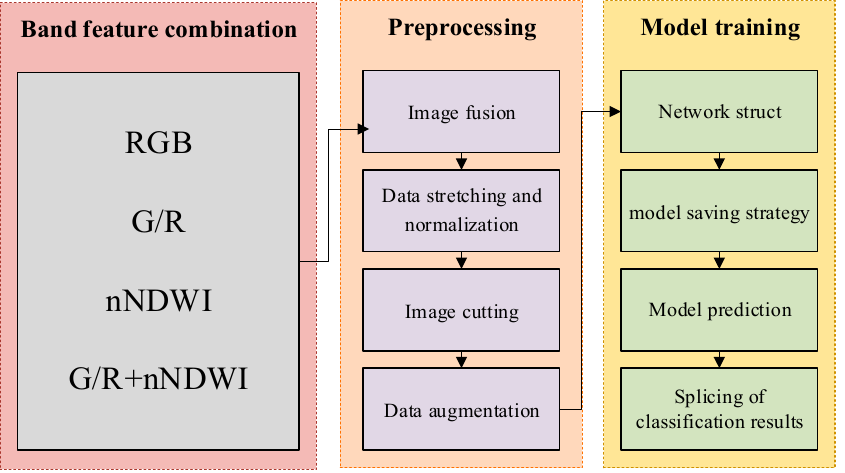
Figure 2. Experimental flowchart of this study used.